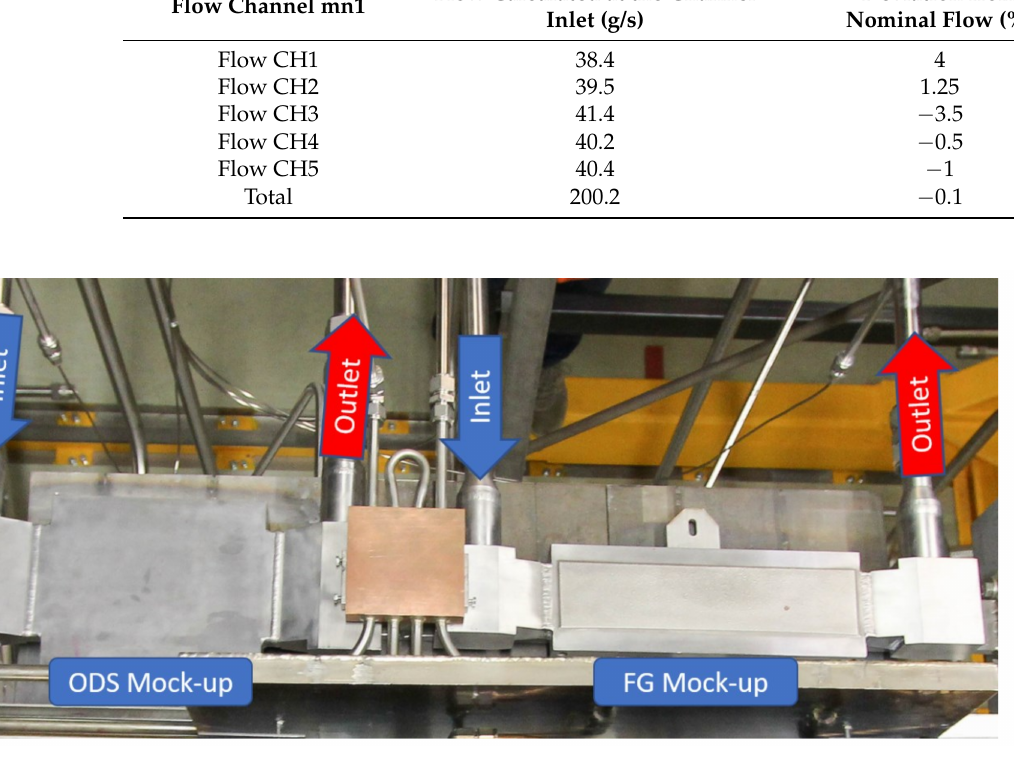
Figure 4. Experimental assembly featuring the two